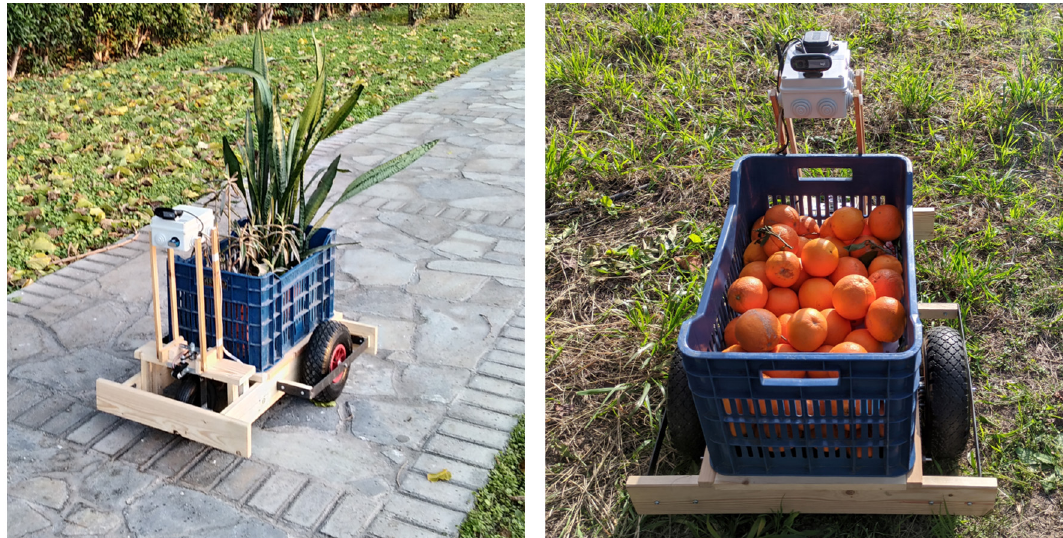
Figure 8. The robotic vehicle in action: the high-level controlling parts, inside the IP55 box, are clearly distinguished as well as the plastic pallet bin carrying testing cargos of 10–15 kg, approximately, on smooth (at the left ) and comparatively rough (at the right ) terrains.